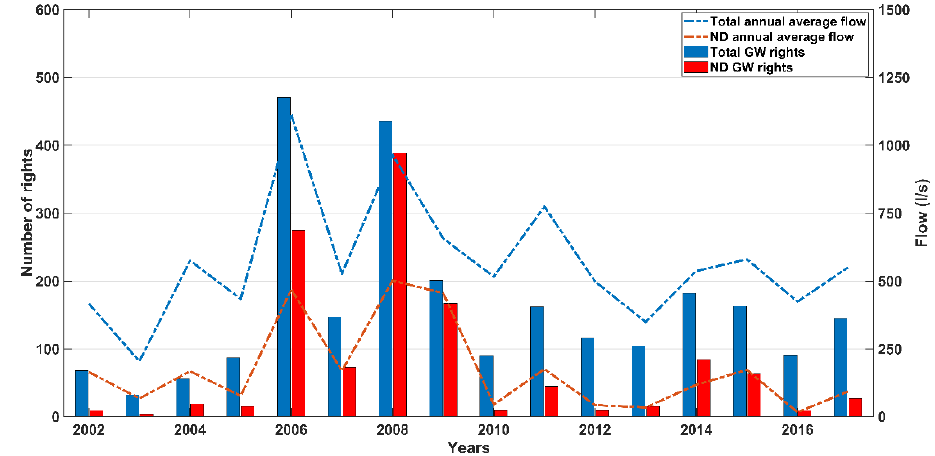
Figure 12. Number and average streamflow of GW rights between 2002–2017.